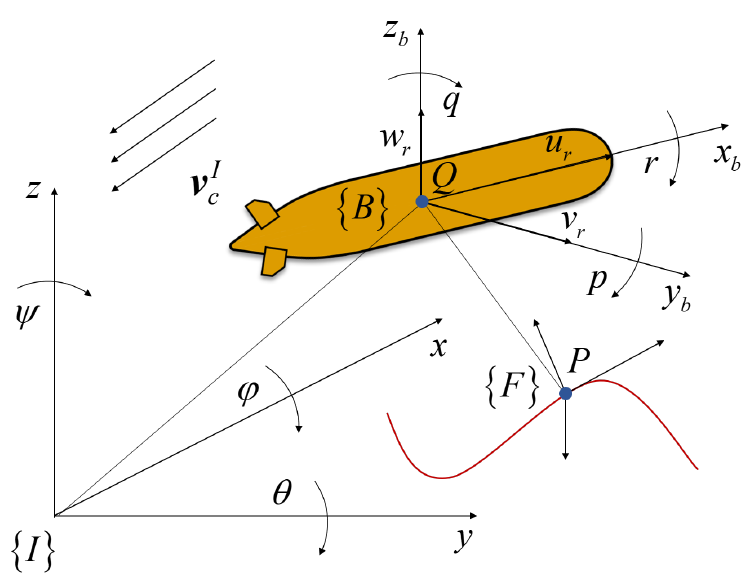
Figure 1. The description for different